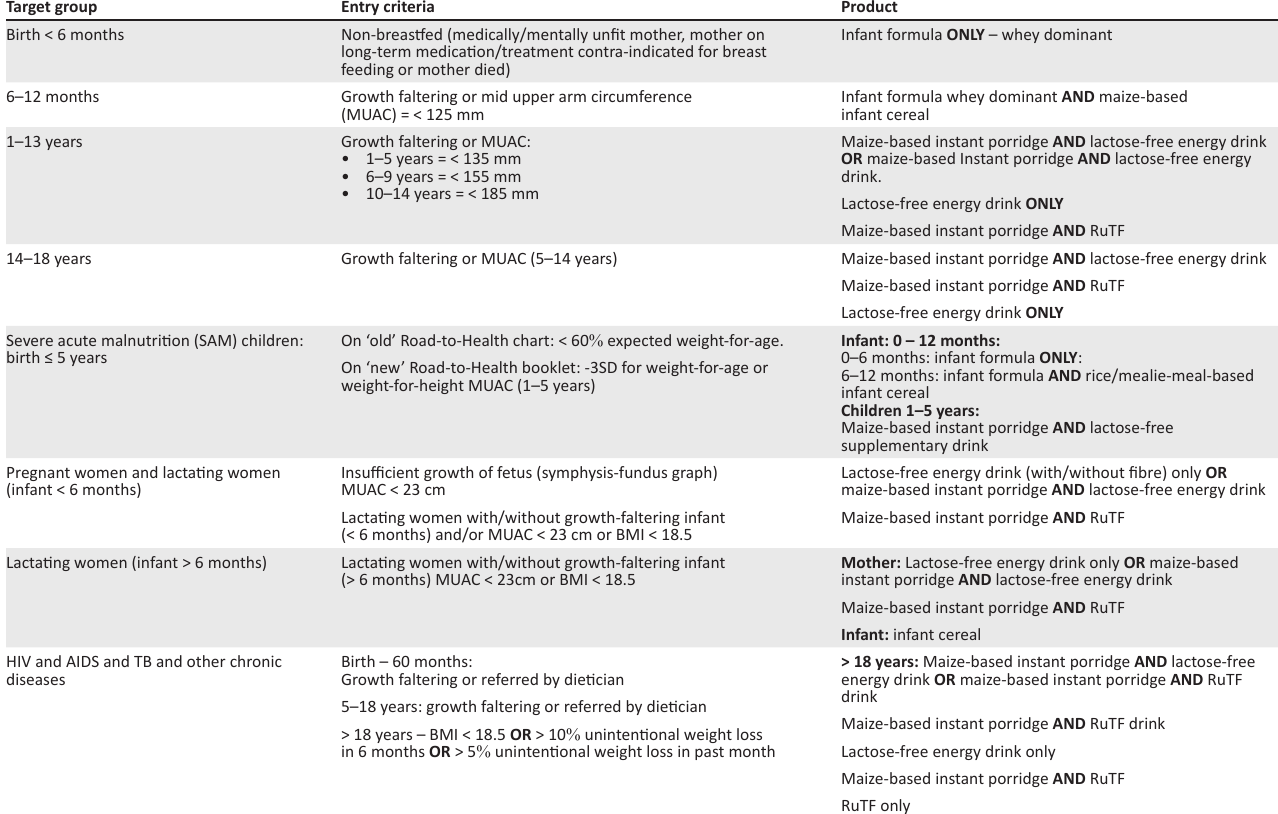
TABLE 1: Current target groups, entry criteria and product options available for patients on the Nutrition Therapeutic Programme in Western Cape Province. Target